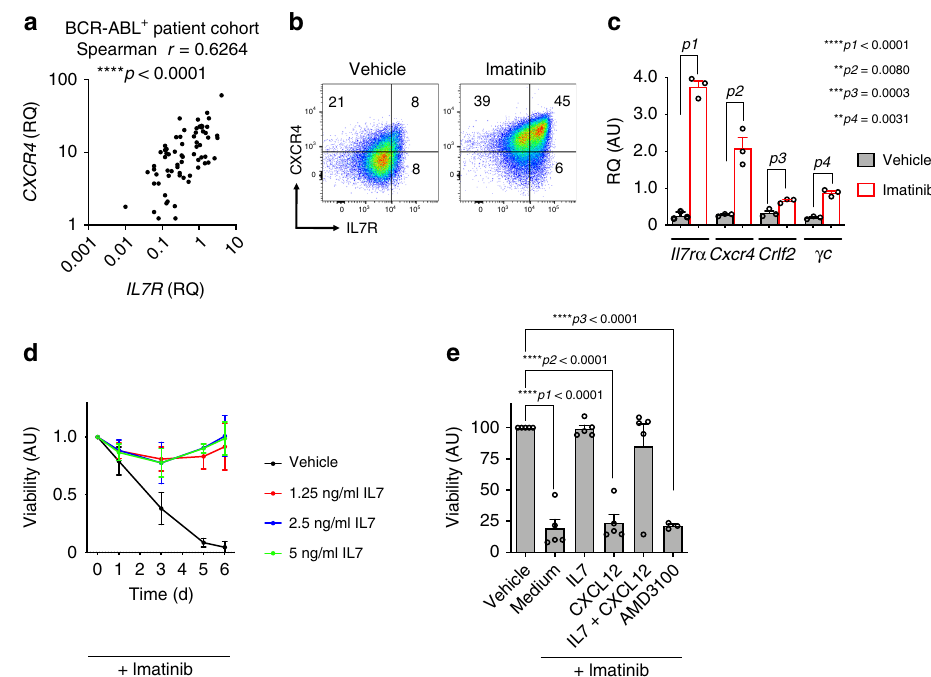
Fig. 2 Regulation of IL7R and CXCR4 expression levels in BCR-ABL + ALL. a Correlation analysis between IL7R and CXCR4 expression levels in 68 pediatric BCR-ABL + ALL patients. Two-tailed Spearman correlation analysis; exact p value = 0.000000011054191. b Flow cytometry analysis showing that imatinib treatment (1 µ M; 15h) leads to increased expression of IL7R and CXCR4 on the cell surface of BCR-ABL1-transformed cells. The results are representative of three independent experiments. c Quantitative RT-PCR showing that Il7r and Cxcr4 and other associated factors are regulated at the level of transcription. N = 3 independent samples per group, and error bars represent mean± SEM. Unpaired t -test, two-sided, p1 exact value = 0.000035569652955. RQ: relative quanti fi cation; AU arbitrary unit. d BCR-ABL1-transformed WT pre-B cells were treated with 1 µ M imatinib and with different concentrations of IL7 as indicated for 6 days. N = 3 independent samples per group, and error bars represent mean ±SD. One-way ANAOVA. Dunnett ’ s multiple comparisons test was performed to day 6, compared with control group (Vehicle). Adjusted p values: Vehicle vs. 1.25 ng/ml IL7 *** p = 0.0003, Vehicle vs. 2.5ng/ml IL7 *** p = 0.0002, Vehicle vs. 5ng/ml IL7 *** p = 0.0002. e Treatment of BCR-ABL1-transformed cells with imatinib leads to cell death and concomitant incubation with IL7, but not CXCL12, reverses this effect. N = 3 independent samples per group, and error bars represent mean ±SEM. Unpaired t -test, two- sided, **** p1 exact value = 0.000003416387742, **** p2 exact value = 0.000002948485097, **** p3 exact value =